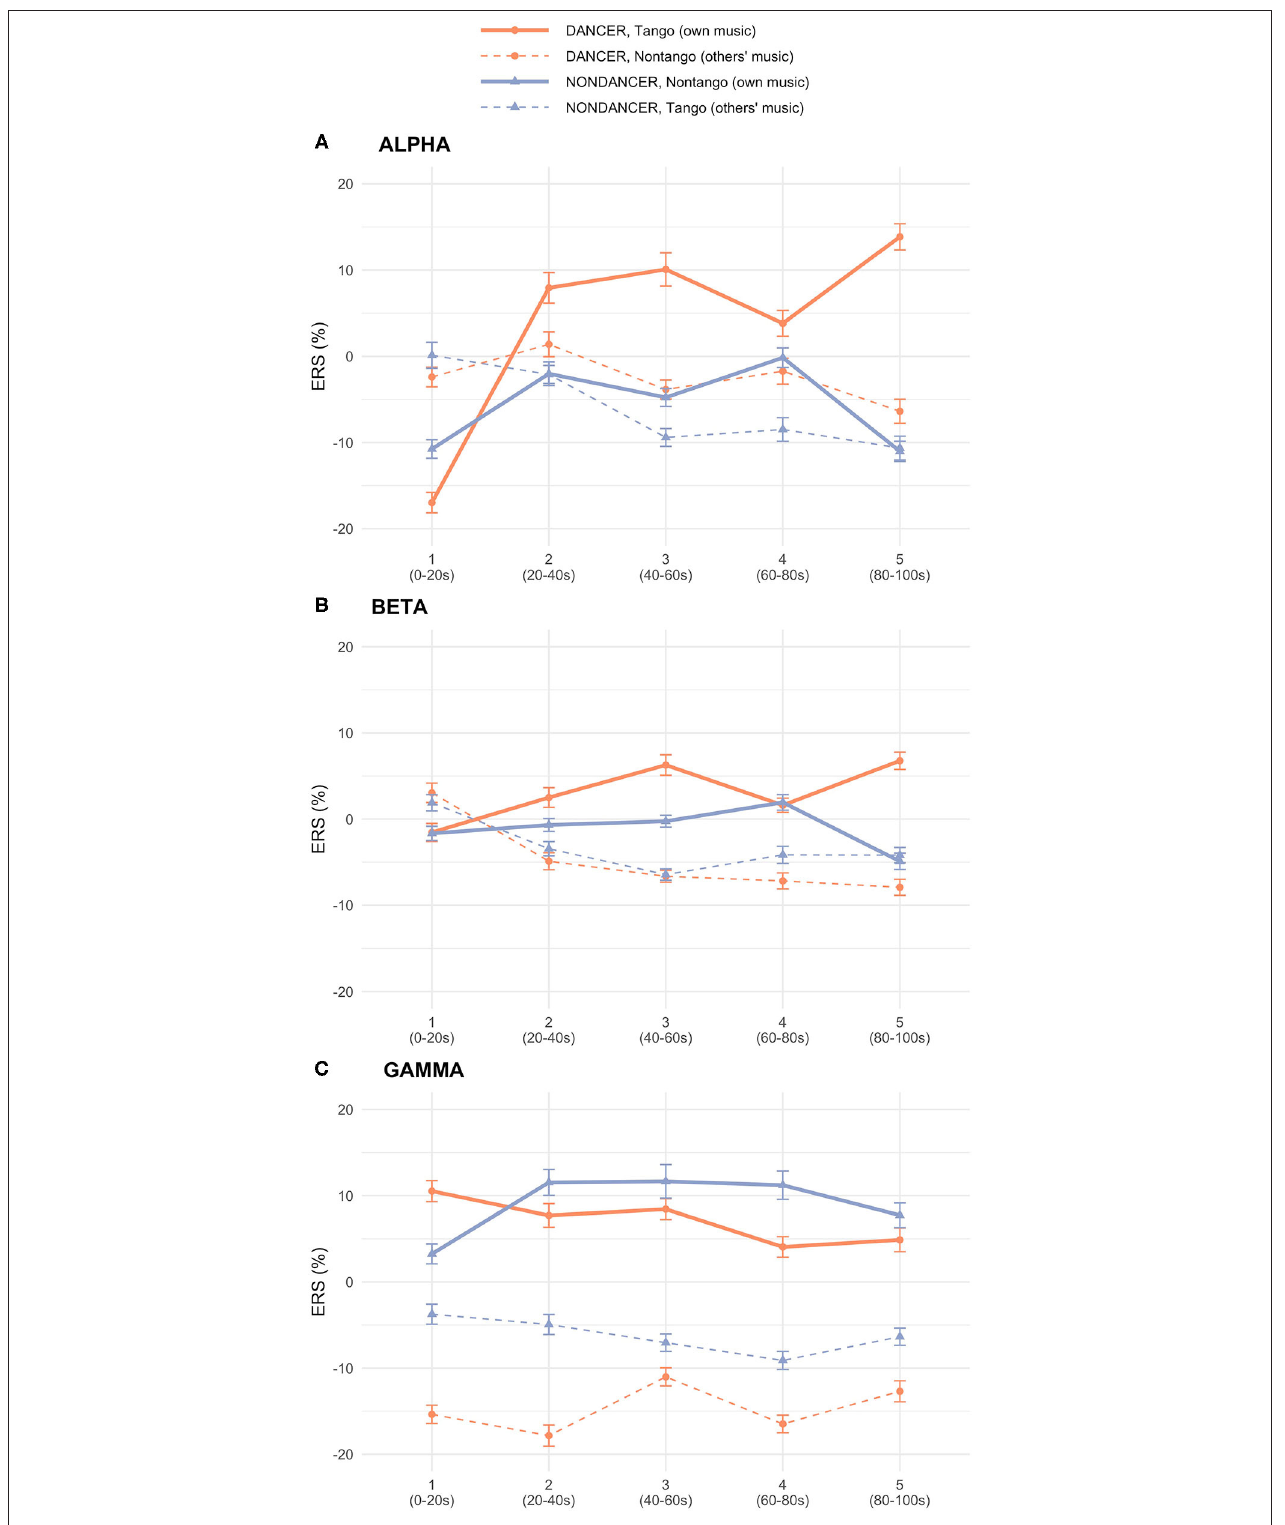
FIGURE 2 | Group × Music × Interval interaction plots of mean ERS in (A) alpha, (B) beta, (C) , and gamma bands. Line plots show mean ERS over each time Interval within each Music condition, per Group.